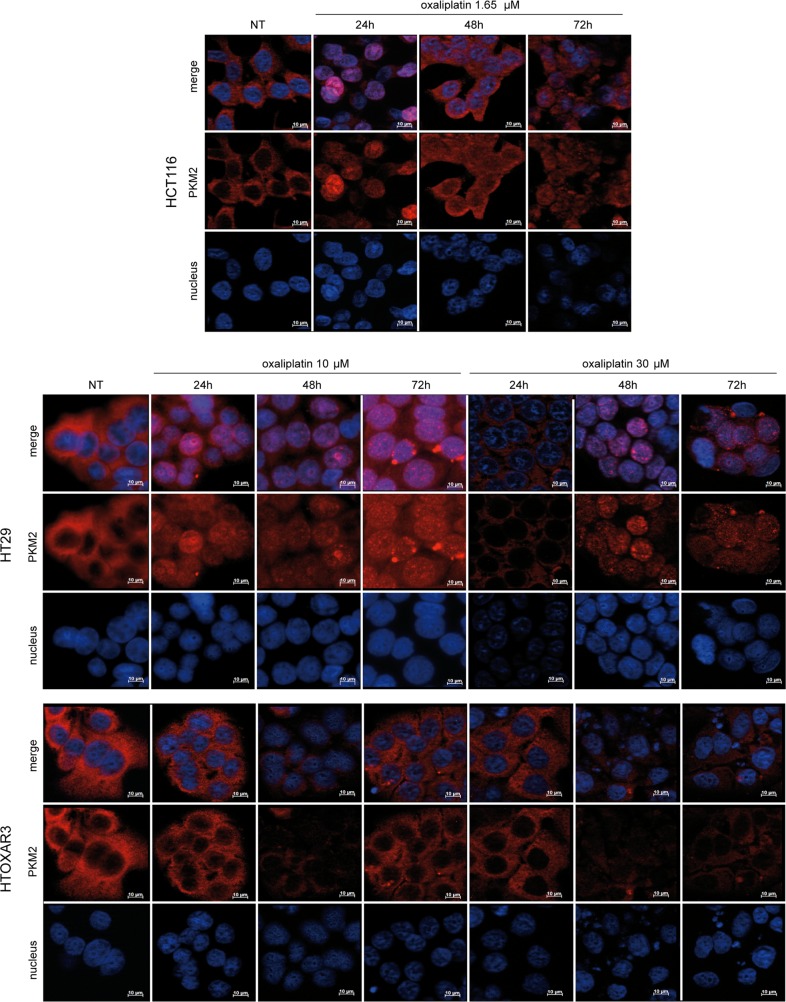
PKM2 subcellular localization in response to OXA in colorectal cancer cell lines.Immunoflourescence staining of PKM2 (red) demonstrates nuclear accumulation in HCT116 and HT29 cells after treatment with OXA in a time and dose-dependent manner but not in resistant HTOXAR3 cells. Nuclei were stained in blue. NT: Non-treated cells. Objective lens: 40x immersion oil. Scale bar: 10 μm.